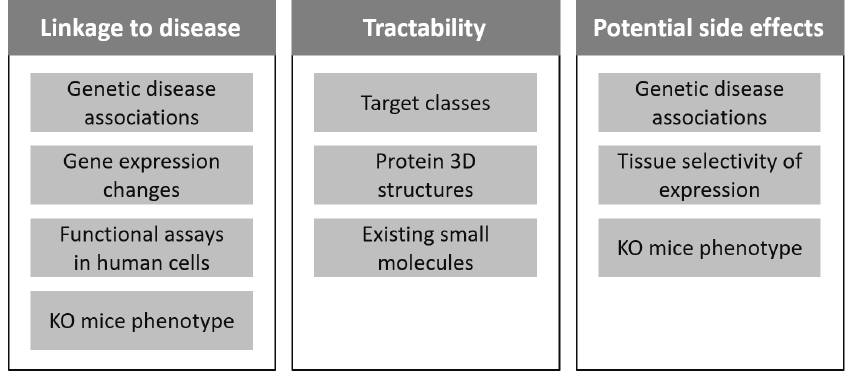
Figure 1. Key factors to be considered in drug target selection. Linkage to disease, tractability and adverse event risk are among the major factors to assess the suitability of novel target candidates. Much of the evidence regarding these factors is available in public domain